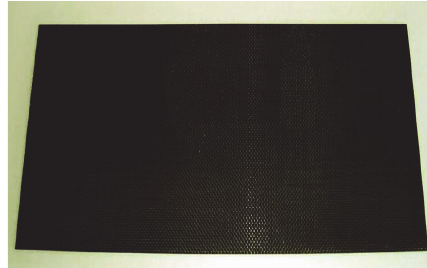
Figure 12: The photograph of the specimen.